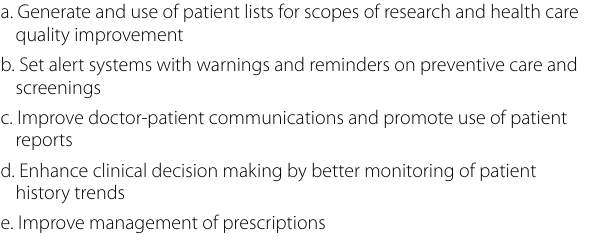
Table 2 Benefits from EHR